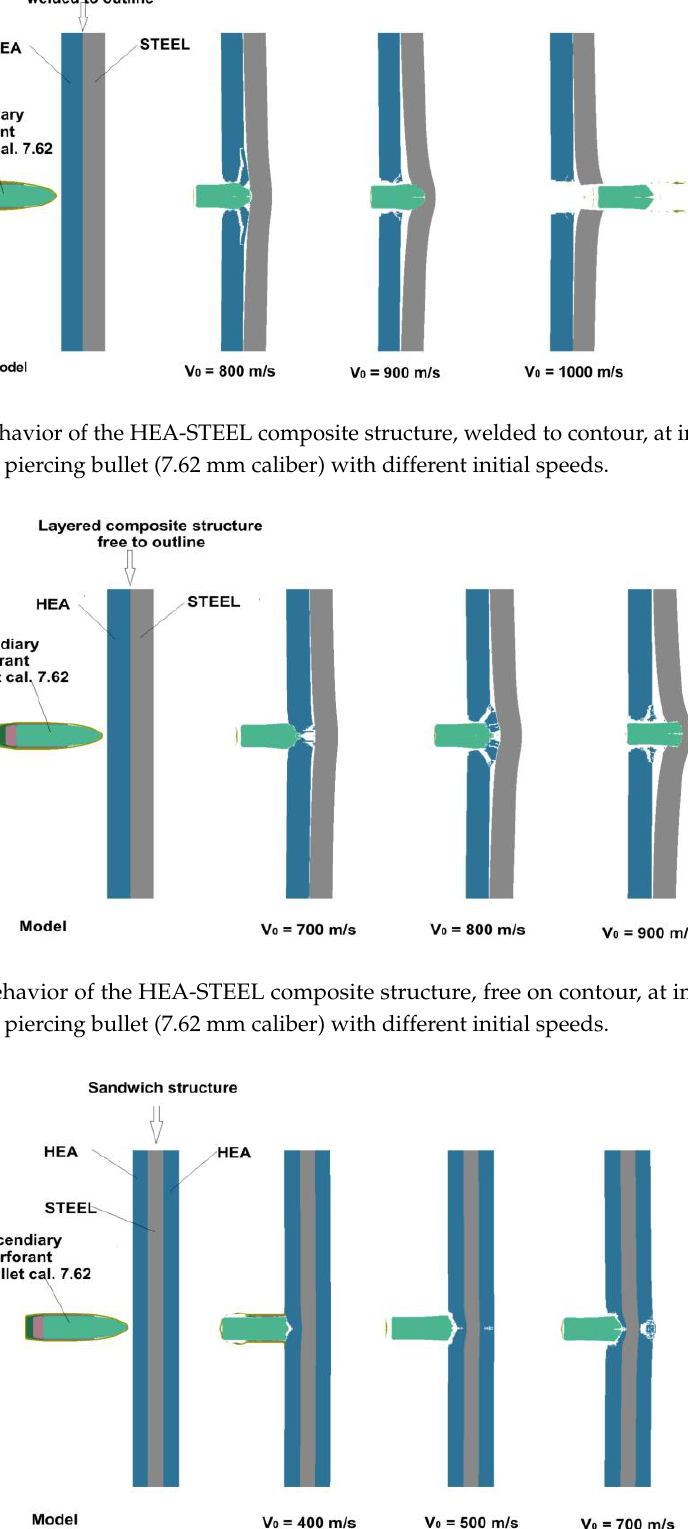
Figure 15. The behavior of the sandwich type composite structure at impact with an incendiary armor piercing bullet (7.62 mm caliber) with different initial speeds.